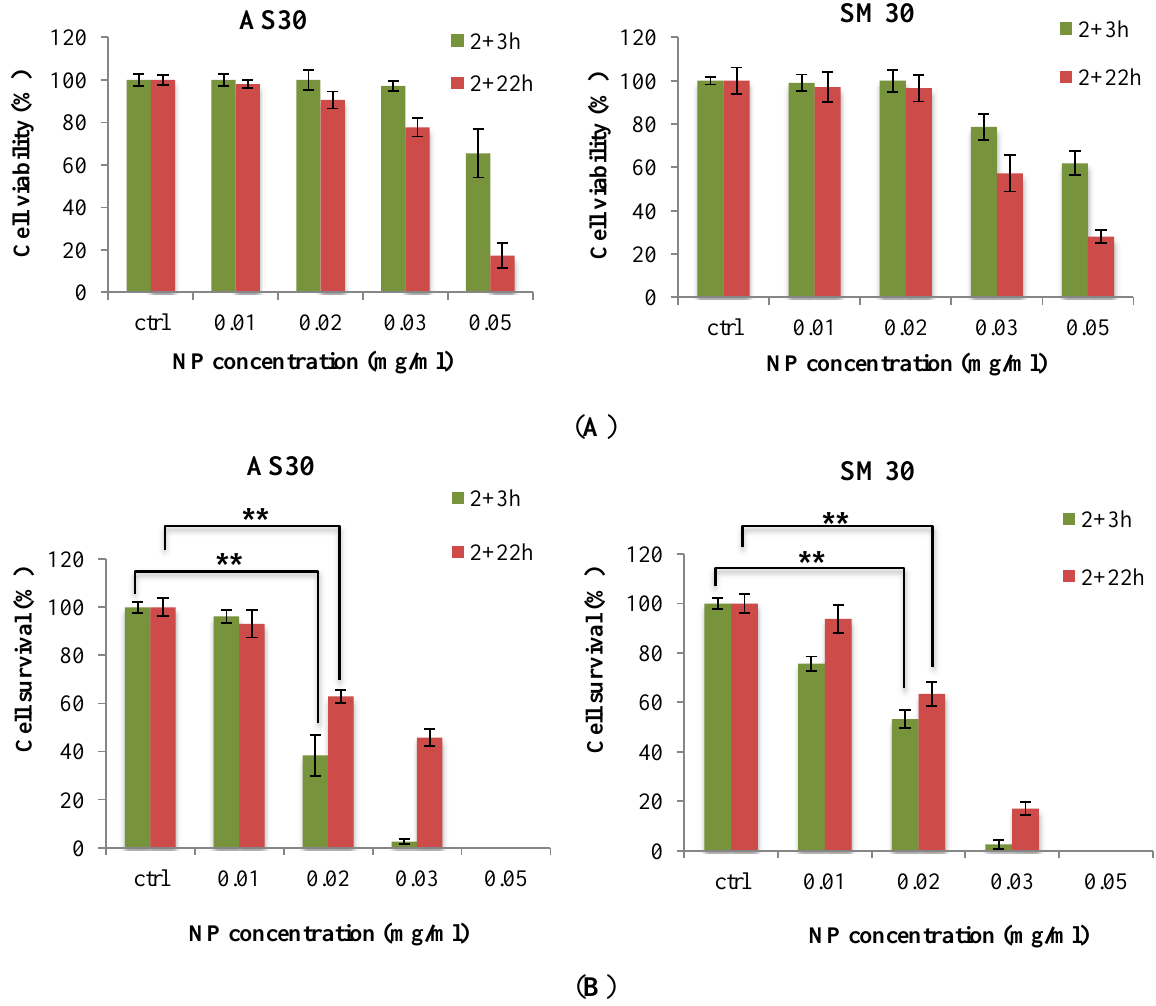
Figure 2. Cytotoxicity of Ludox  NPs AS30 and SM30 in A549 cells was assessed in relation to NP concentration and recovery time after the treatment (3 or 22 h) by MTS assay ( A , cell viability) and clonogenic assay ( B , cell survival: cloning efficiency of treated/untreated control